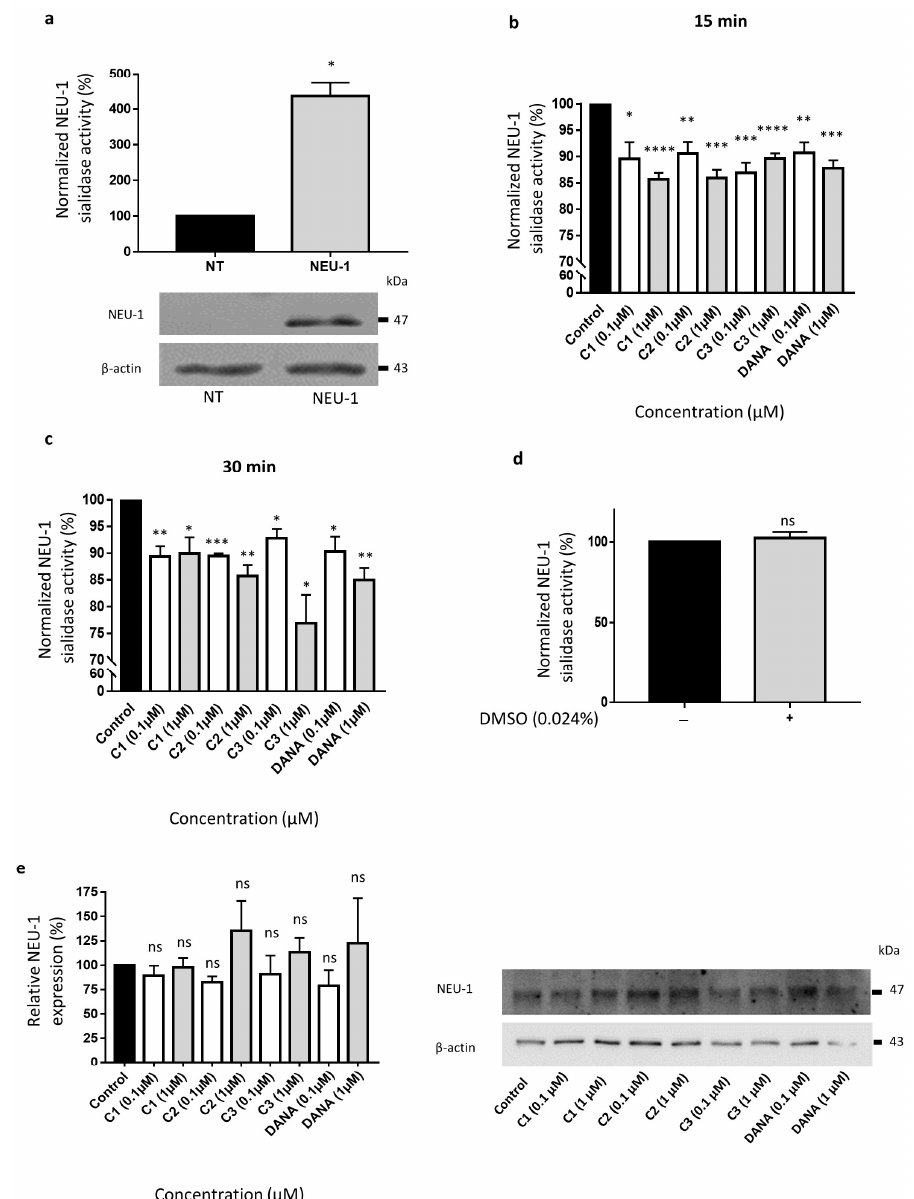
Figure 3. Effects of N-Acetyl-2,3-dehydro-2-deoxyneuraminic acid and compounds 1 – 3 on membrane NEU-1 sialidase activity in NEU-1 overexpressing cells. ( a ) Sialidase activities in untransfected (NT) and transfected (NEU-1) COS-7 cells. The bottom panel indicates the expression of NEU-1 in untransfected (NT) and transfected (NEU-1) COS-7 cells. β -actin was used as an internal control ( n = 3) ( t test). ( b ) Normalized sialidase activity after 15 min incubation with the vegetal compounds at 0.1 or 1 µ M and comparison with DANA ( n = 5–6) ( t test). ( c ) Normalized sialidase activity after 30 min incubation with DANA and the compounds 1 – 3 at 0.1 or 1 µ M. Results are represented compared to the nothing condition normalized to 100% ( n = 3–6) ( t test). ( d ) Effects of DMSO alone on NEU-1 sialidase activity ( n = 7) ( t test). ( e ) Relative NEU-1 expression in presence of the vegetal compounds and DANA at 0.1 and 1 µ M. The expression of NEU-1 was normalized to β -actin ( n = 3), (ANOVA), (C1: feddeiketone B, C2: 2,3-Dihydroxy-1-(4-hydroxy-3,5-dimethoxyphenyl)-1-propanone, C3: syringylglycerol, DANA: N-Acetyl-2,3-dehydro-2-deoxyneuraminic acid), (ns: non-significant, * p < 0.05, ** p < 0.01, *** p < 0.001, **** p < 0.0001).